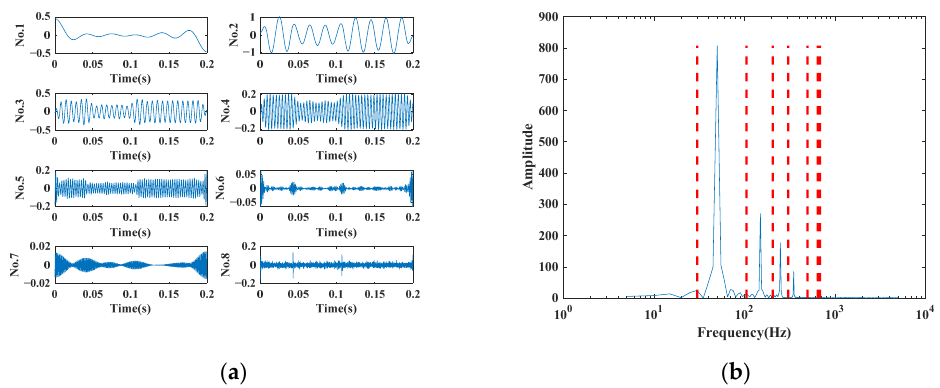
Figure 9. PQD signal decomposition results by EWT when K = 8. ( a ) Results in the time domain; ( b ) Segmented spectrum.